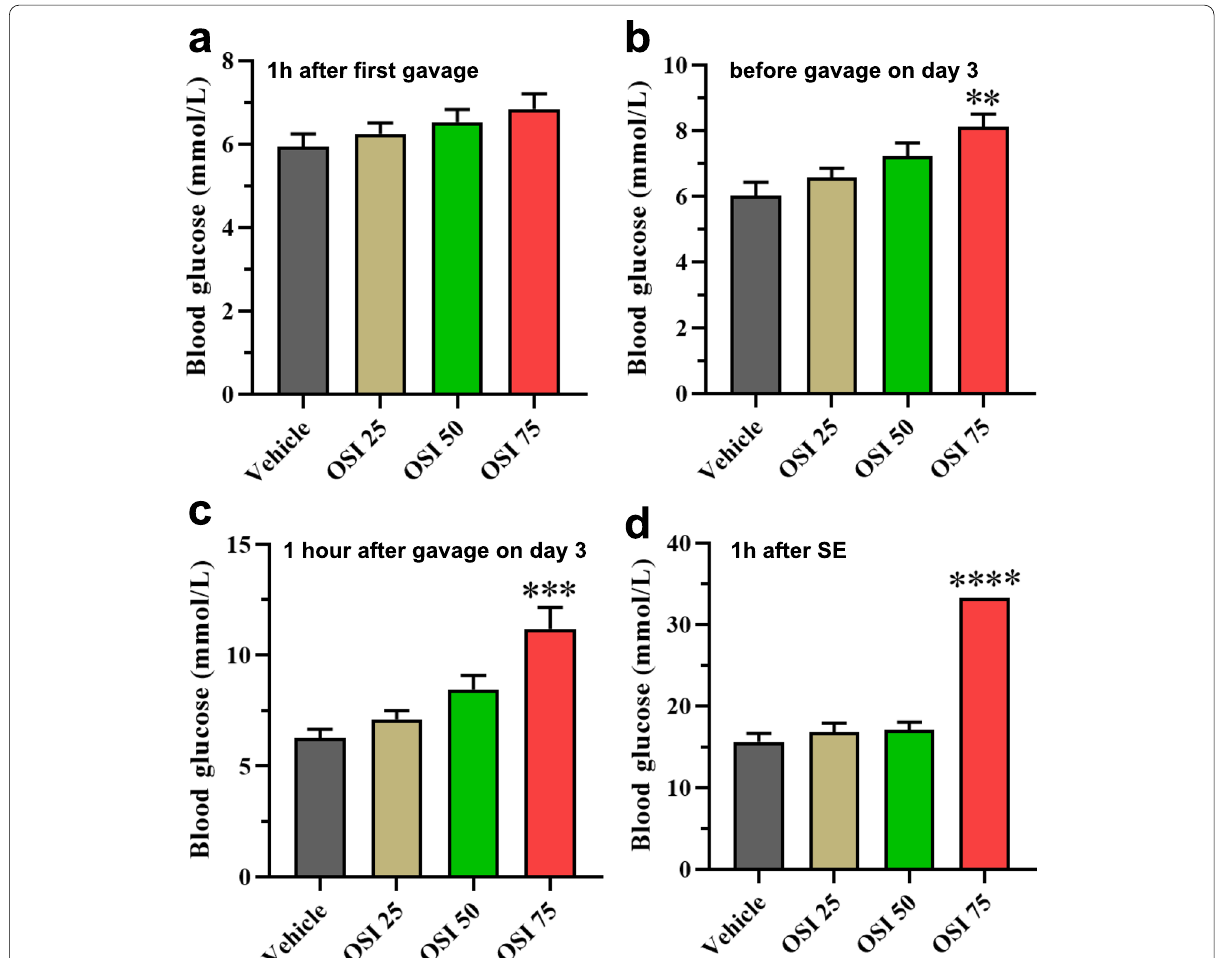
Fig. 4 Effect of OSI-906 treatment on blood glucose before and after the seizures. ( a ) Blood glucose level did not significantly change at 1 h after the first OSI-906 gavage, compared with the control group ( P > 0.05). ( b & c ) OSI-906 at 75 mg/kg significantly increased the blood glucose at fasting or 1 h after gavage on day 3. P 0.0024 and 0.0002, respectively, vs the control, one-way ANOVA. ( d ) In the 75 mg/kg OSI-906 group, blood glucose = levels were higher after the seizure compared with the control group. Data are shown as mean